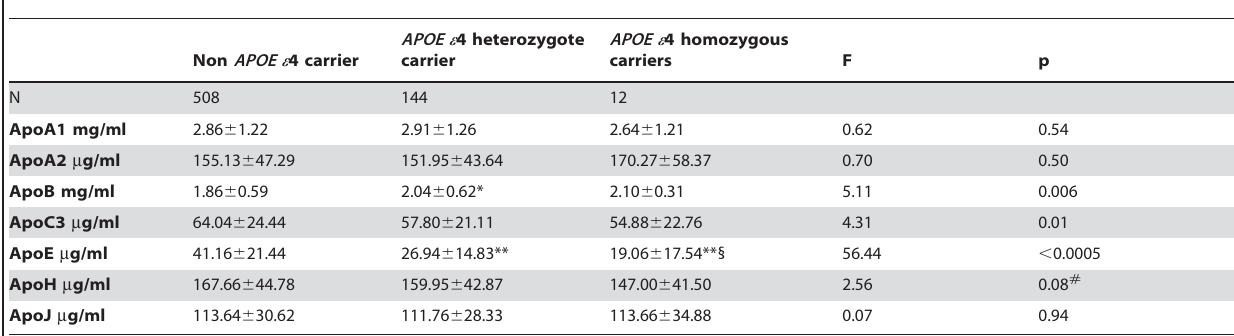
Table 2. Apolipoprotein levels in different APOE e 4 carrier